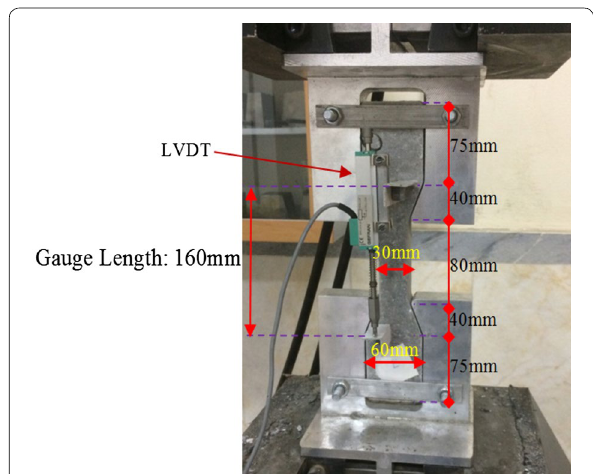
Fig. 5 Uniaxial tension test setup and specimen geometry.